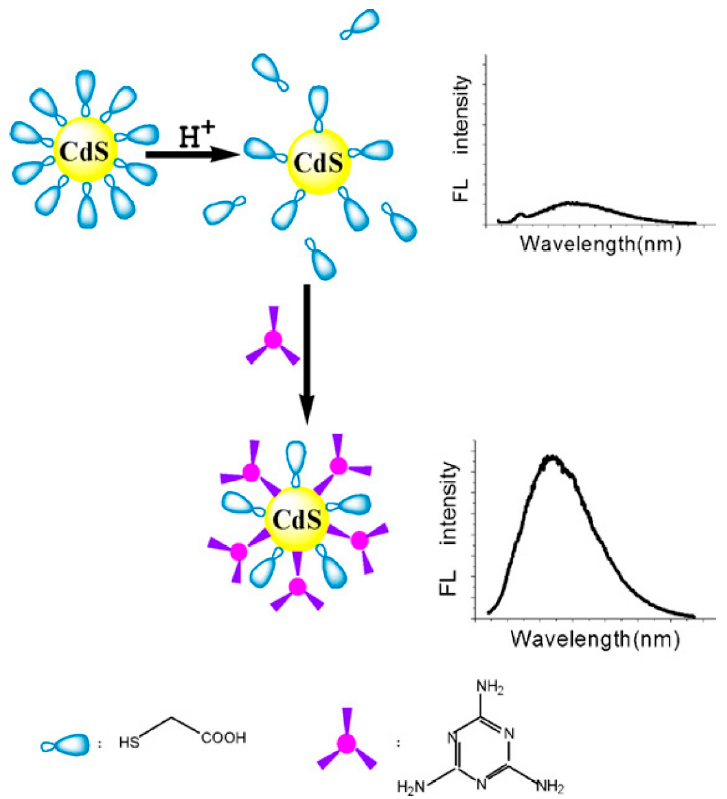
Figure 5. Scheme illustrating the interaction of melamine (MA) with thioglycolic acid (TGA) -capped cadmium sulfide quantum dots (CdS QDs) (reproduced with permission from Reference [42]).